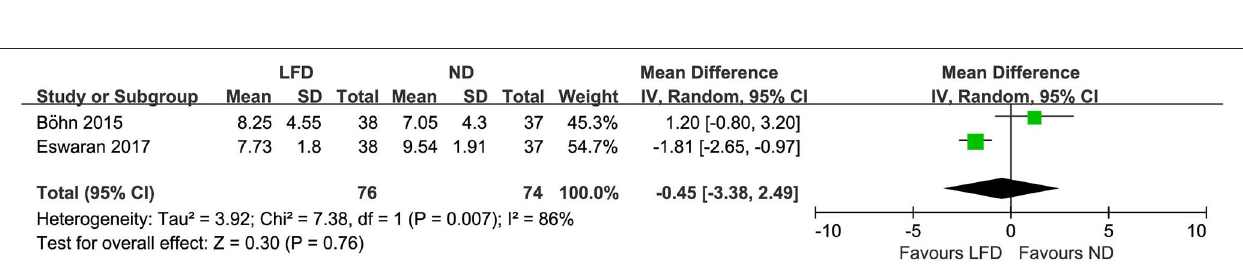
FIGURE 6 | Pooled mean difference for irritable bowel syndrome-related quality of life (IBS-QOL). LFD, low-FODMAP diet; ND, normal diet.